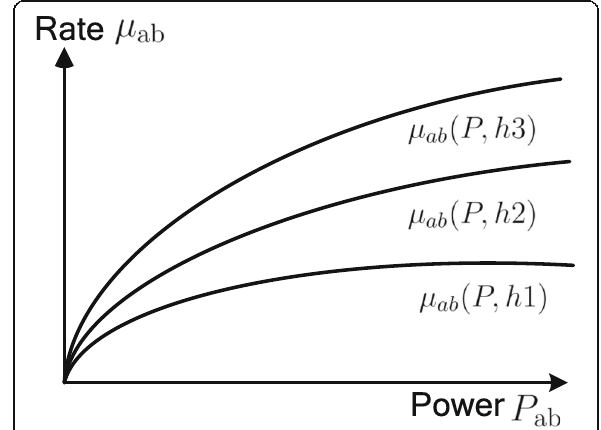
Fig. 3 Set of rate-power curassumed to be monotonicallyions h 1 <h 2 < h